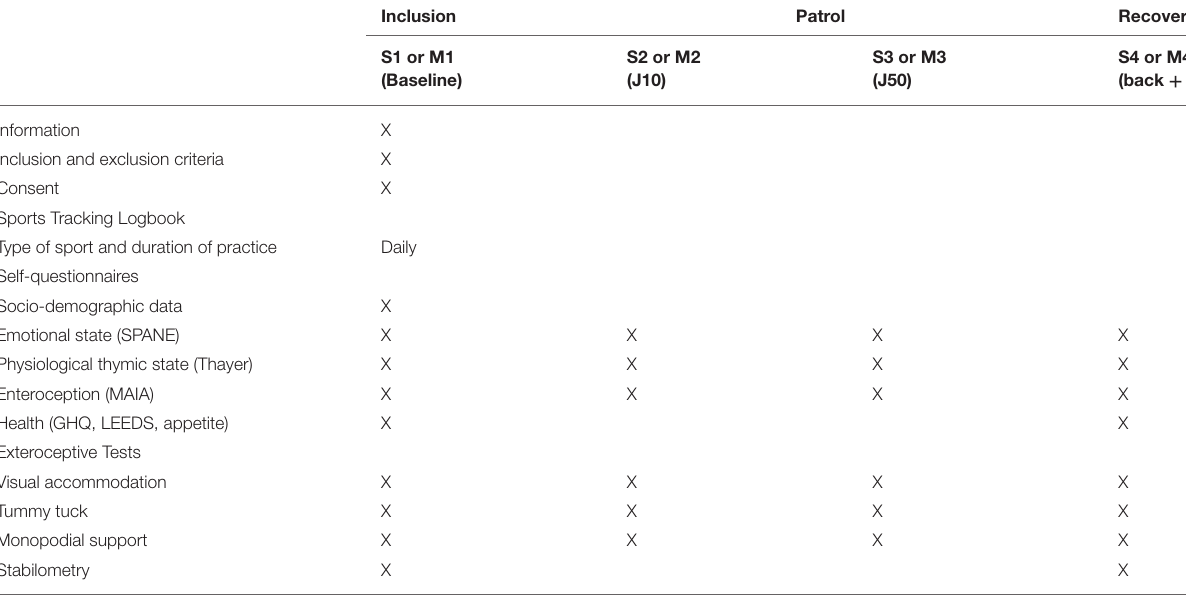
TABLE 1 | Planning of measures.